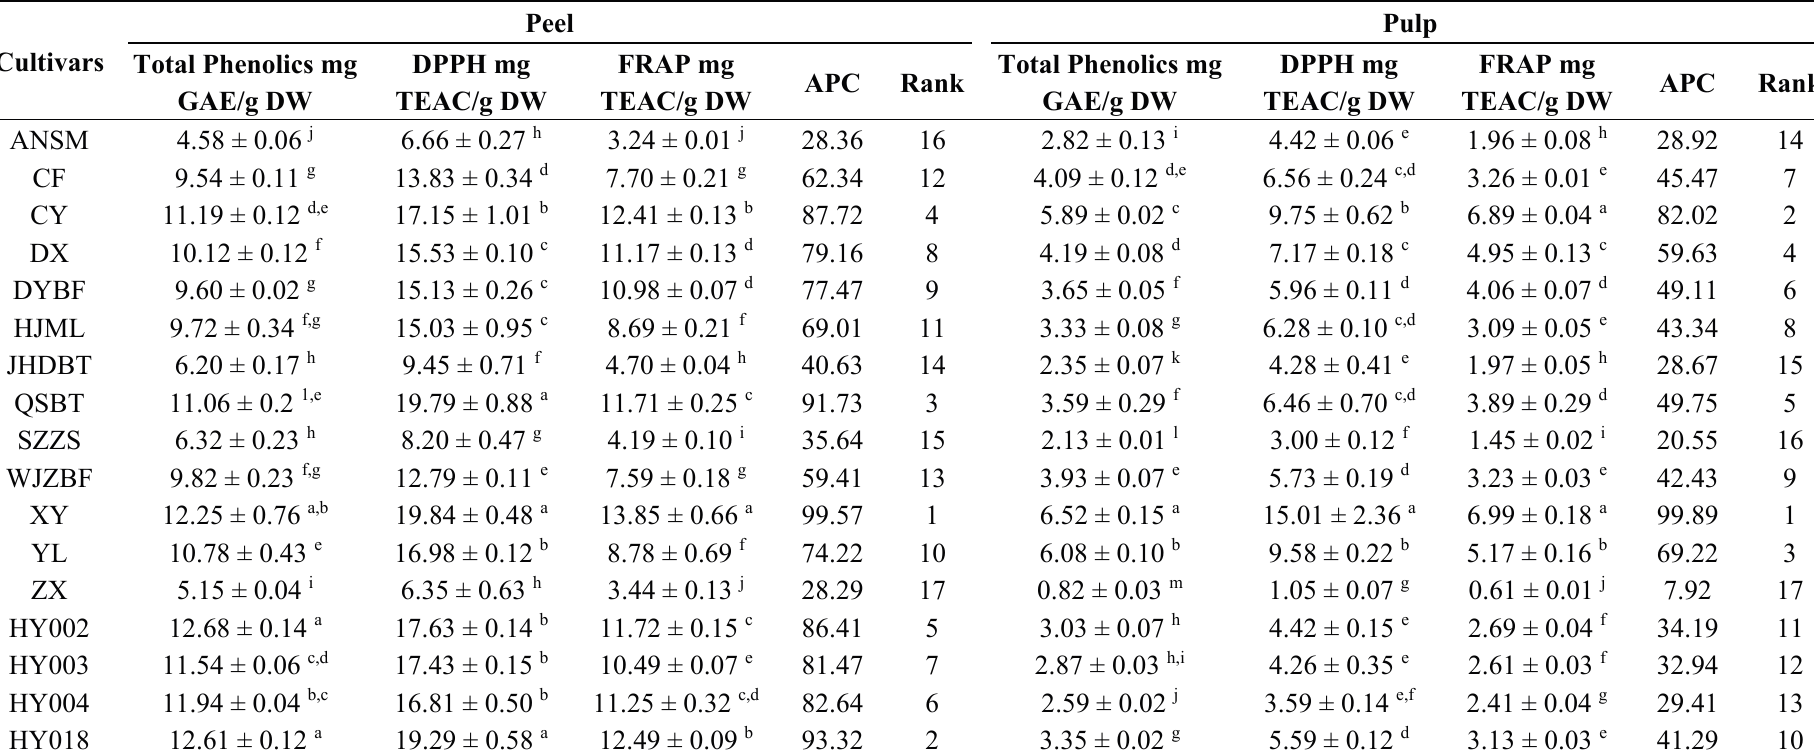
Table 5. Total phenolic contents and antioxidant activities in the peel and pulp extracts of 17 P. persica cultivars.